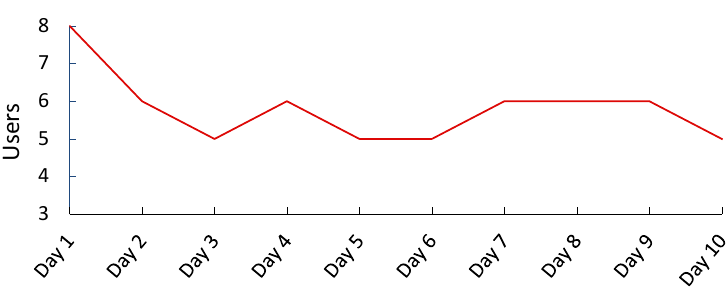
Figure 1. Number of users that completed the questionnaire each day. Table 5. User compliance rates.